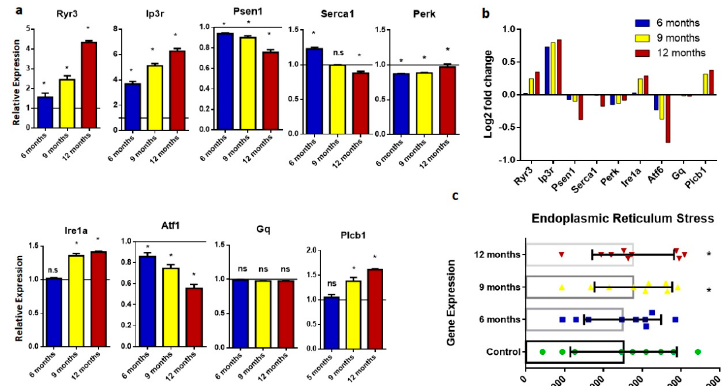
Figure 3. Expression analysis of genes involved in endoplasmic reticulum stress. ( a ) Histograms representing relative mRNA expression of Ryr3 , ire1a , Ip3r , atf1 , Psen1 , Gq , Serca1 , Plcb1 , and Perk . Represented values are the mean and SD obtained from three individual experiments performed for each sample. The line on the x-axis at 1.0 represents the gene expression of control samples. ( b ) Bar plots representing fold-change values represented in the log2 scale showing gene expression in the brain of six-, nine-, and 12-month-old samples. Baseline shows expression in control samples. ( c ) Scattered-dot plot showing expression of genes involved in endoplasmic reticulum stress. * Expression is significantly different from WT ( p ≤ 0.05). n.s., Nonsignificant.